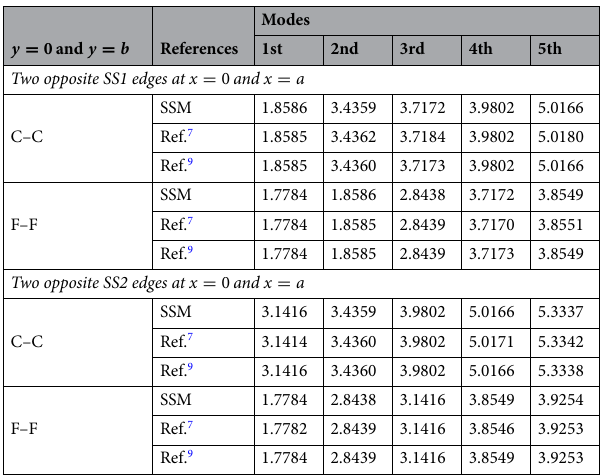
Table 4. The first five frequency parameters ( (cid:31) iso ) of representative Lévy-type isotropic plates with b and ν = 0.3 .